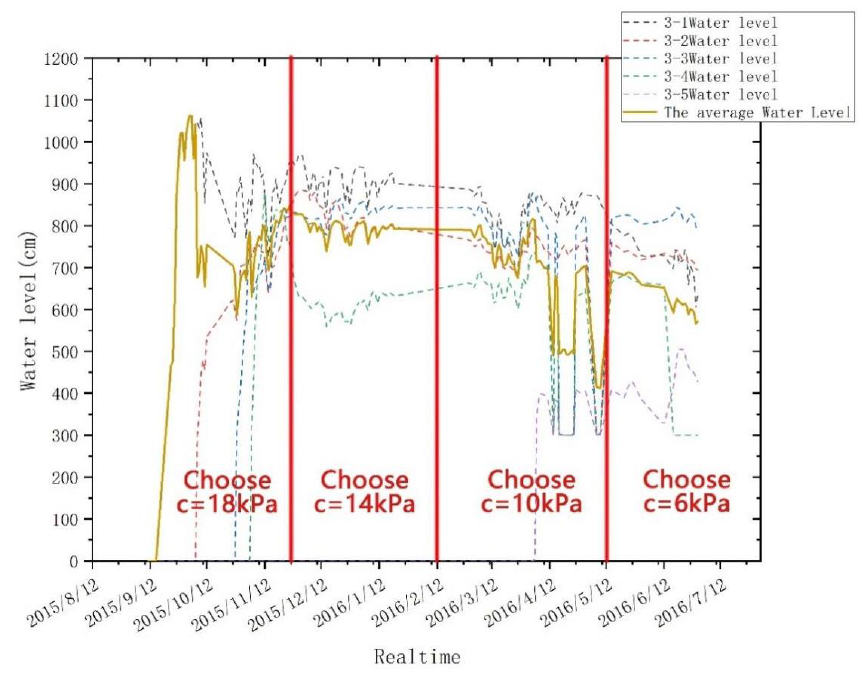
Figure 11. Principles of landslide early warning model at different leaching stages (c refers to cohesion in the figure).